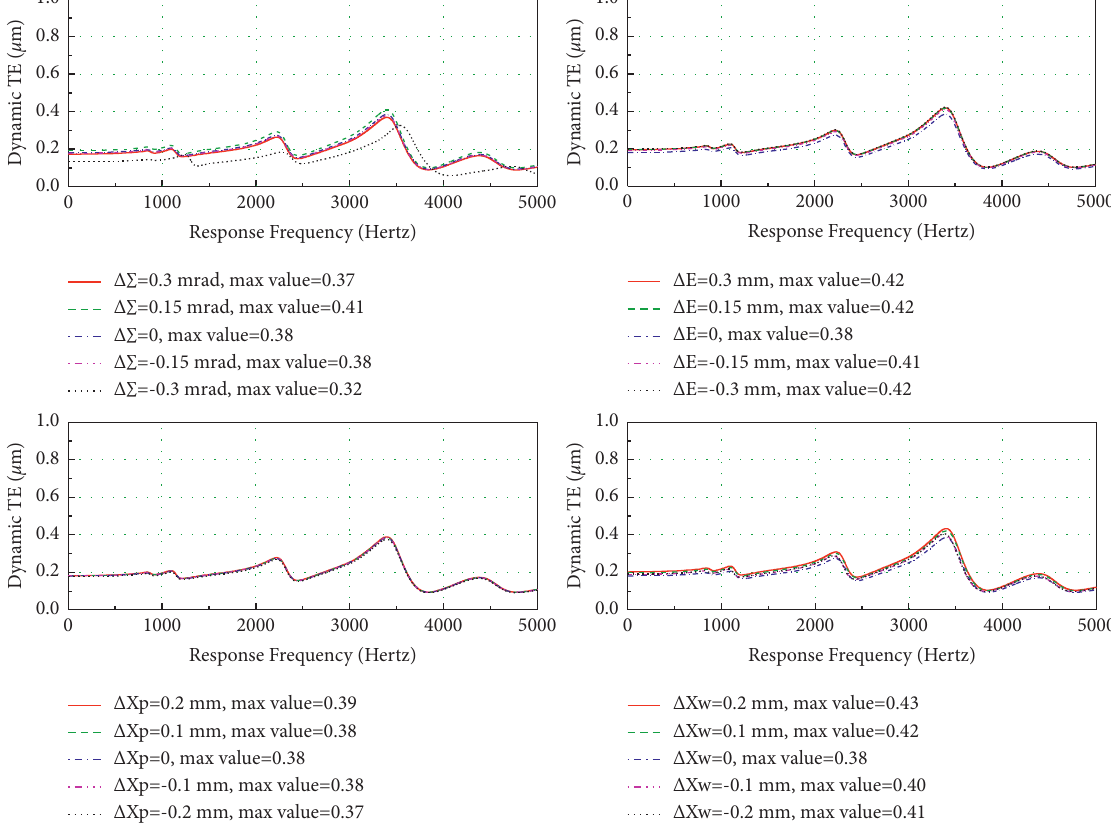
Figure 13: Dynamic transmission error in frequency domain.